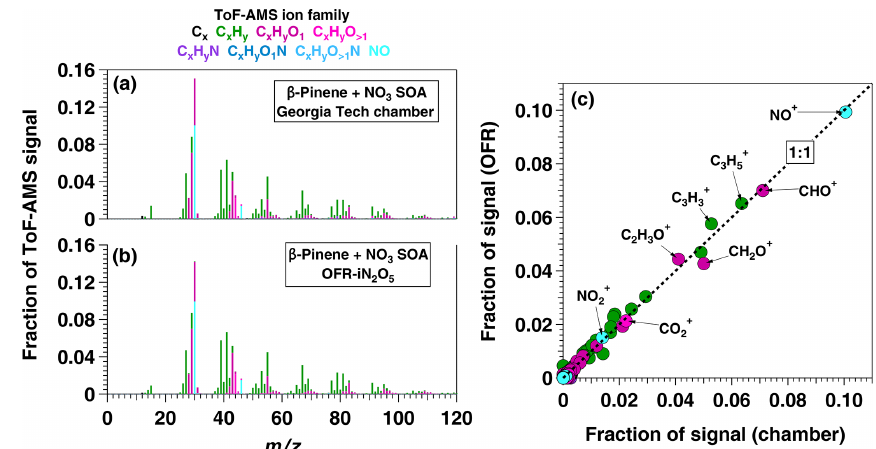
Figure 11. AMS spectra of SOA generated from NO 3 oxidation of β -pinene in (a) the Georgia Tech environmental chamber (Boyd et al., 2015) and (b) OFR-iN 2 O 5 . The scatter plot in (c) shows spectra generated in the OFR and in the chamber plotted against each other.